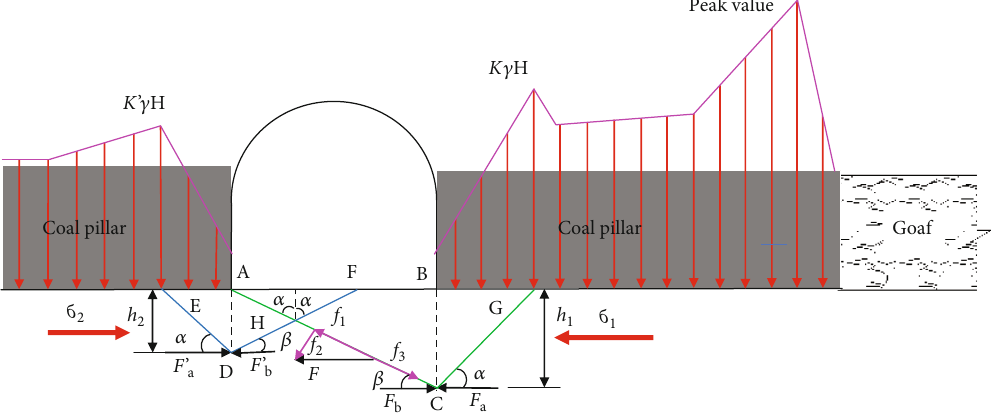
Figure 5: Mechanical model of fl oor